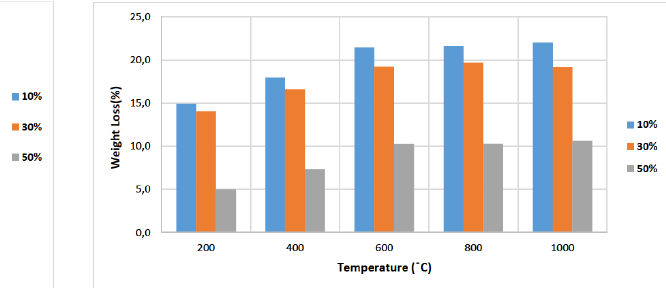
Figure 10: The absorption coeflcient of geopolymer foams with different content of basalt waste fibre at high temperature.